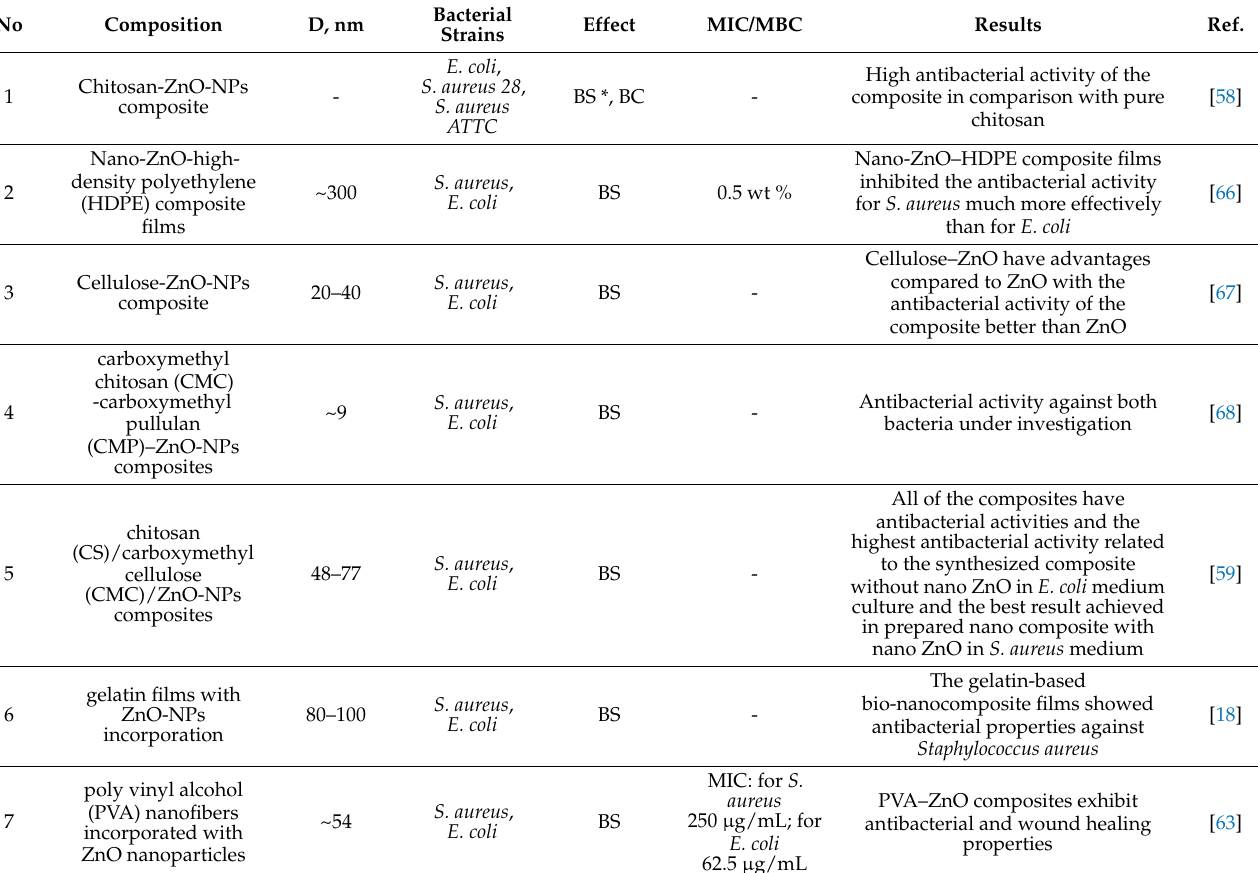
Table 1. The main parameters of ZnO-NPs–polymer composites reported in other modern